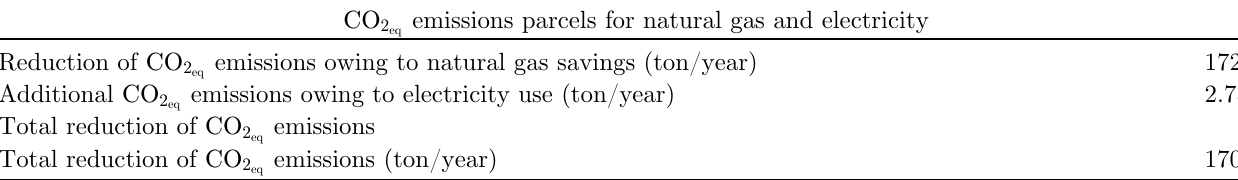
Table 8. Reduction of equivalent carbon dioxide